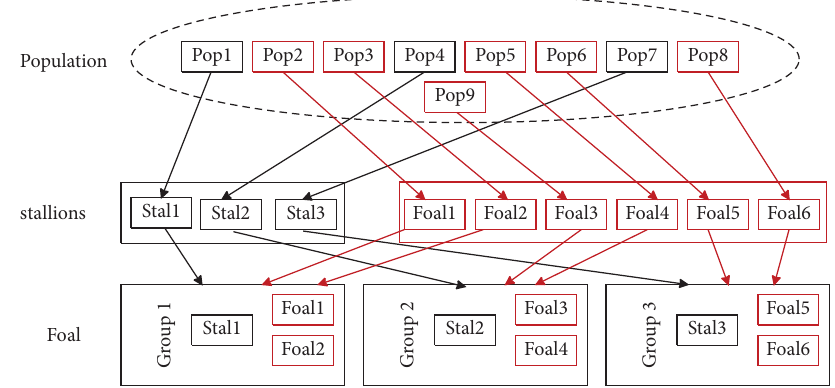
Figure 2: Groups’ formation from the original